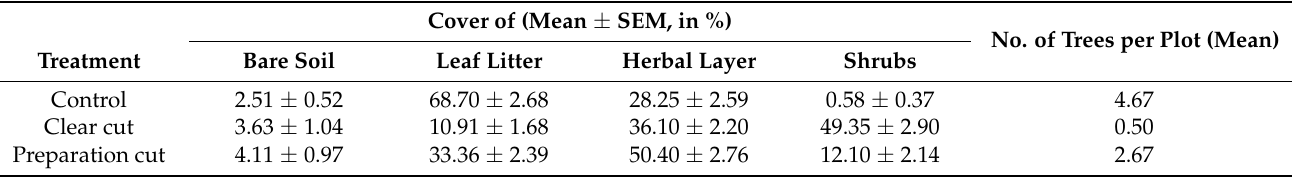
Table 1. Environmental characteristics of forestry treatments represented as the cover of bare soil, leaf litter, herbal layer and shrubbery and the average number of trees per plot. Cover of (Mean ± SEM, in %) No. of Trees per Plot (Mean) Treatment Bare Soil Leaf Litter Herbal Layer Shrubs Control 4.67 Clear